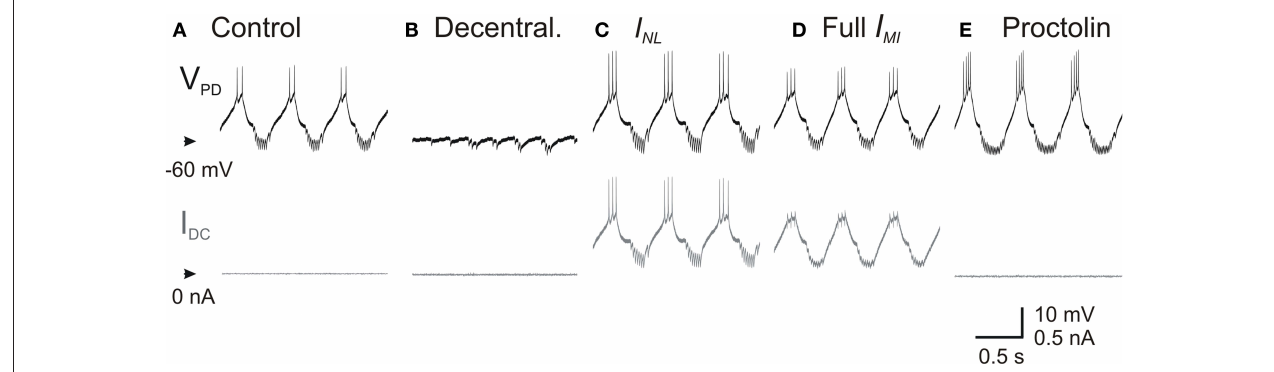
Figure  | effect of proctolin on the activity of PD neurons. Top traces correspond to the membrane potential of a PD neuron and the bottom traces to the injected dynamic clamp current in (A) control, (B) after decentralization, (C) during injection of I g = − 80 nS, and (e) during bath application of 1-μM MI